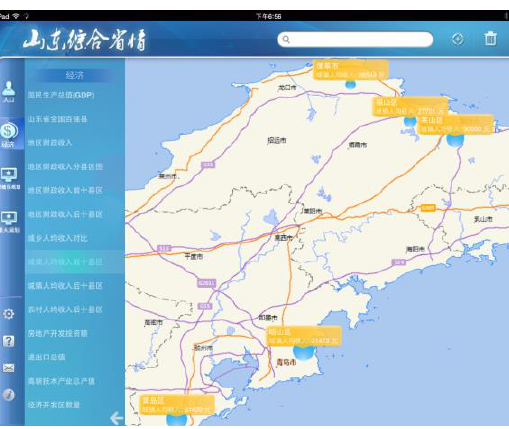
Figure 3. The number of Economic Development Zones in